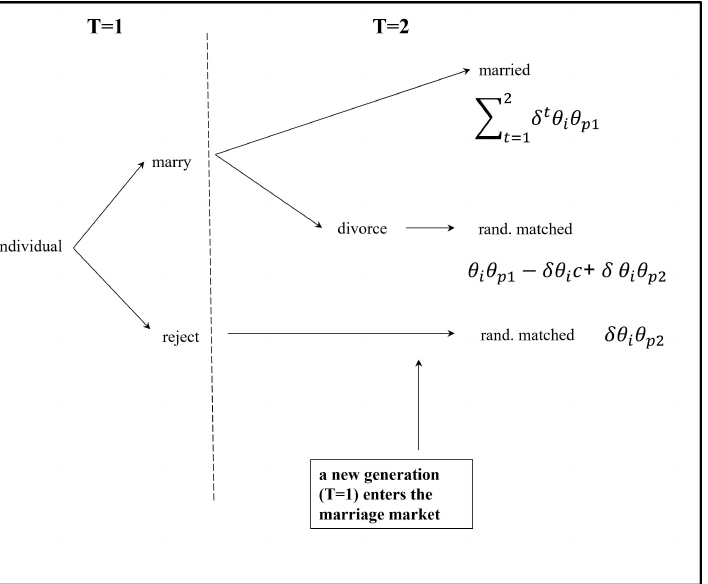
Figure 8. Timing and total utilities in a 2-periods game with one younger generation entering the